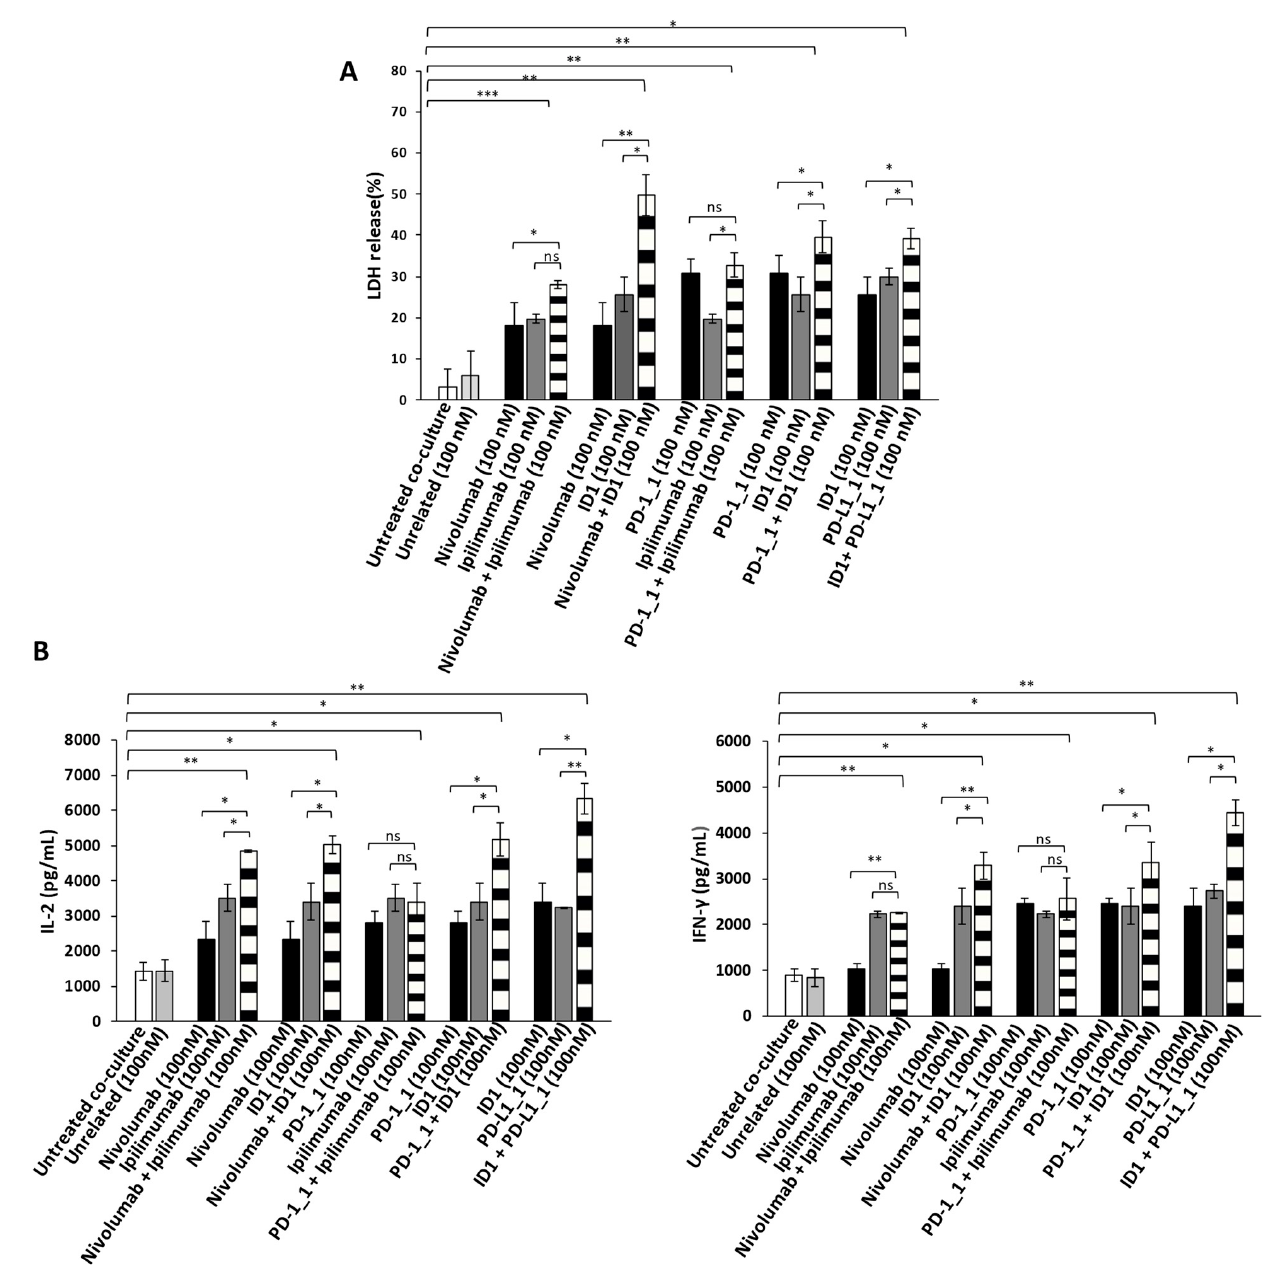
Figure 5. Anti-tumor effects of Immunomodulatory mAbs on MDA-MB-231 tumor cells co-cultured with hPBMCs. ( A ) Evaluation of tumor cell lysis by detecting LDH release from MDA-MB-231 tumor cells co-cultured with hPBMCs, for 48 h in the absence or presence of immunomodulatory mAbs, used alone (black and dark grey bars) or in combination (striped bars), at the indicated concentrations. ( B ) Activation of lymphocytes by anti-PD-1, anti-PD-L1 or anti-CTLA-4 mAbs was analyzed by evaluating the secretion of IL-2 and IFN- γ in the supernatant of the treated co-cultures. Cytokines are expressed as pg/mL. The values were reported as the mean of at least three determinations obtained in three independent experiments. Error bars depict means ± SD *** p < 0.001; ** p < 0.01; * p < 0.05; ns, not significant.